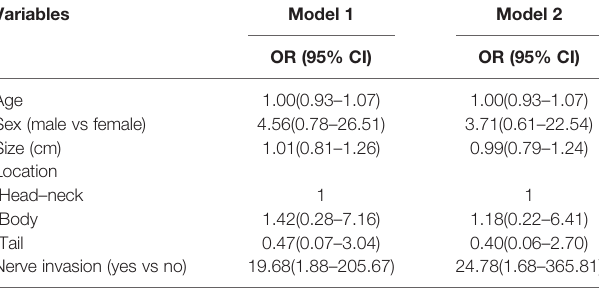
TABLE 4 | Logistic regression analysis in evaluating aggressive behavior in patients with G3 PNET (n = 50).